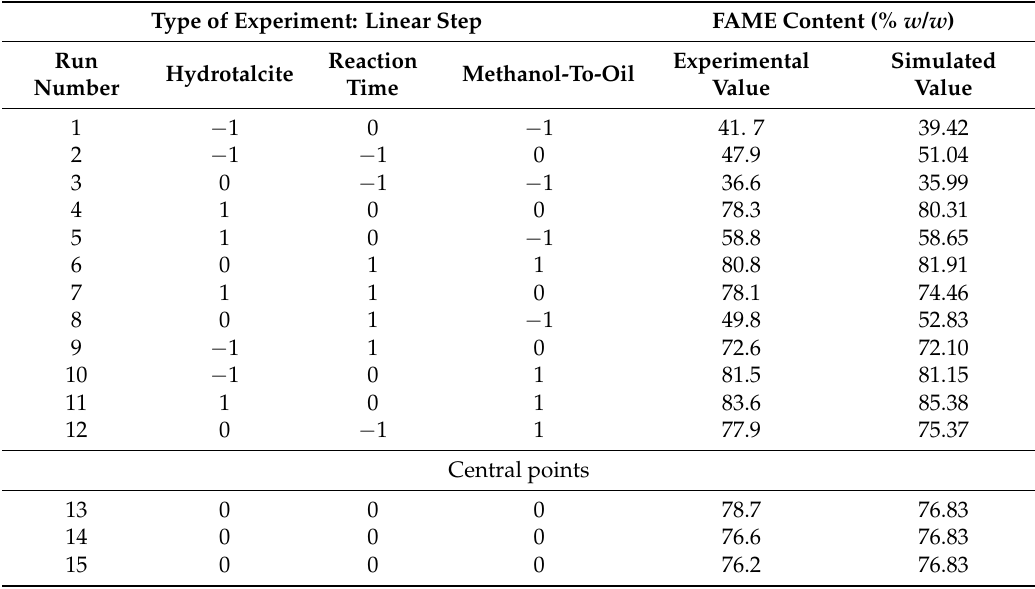
Table 3. Experimental design for biodiesel optimization—predicted fatty acid methyl ester (FAME)